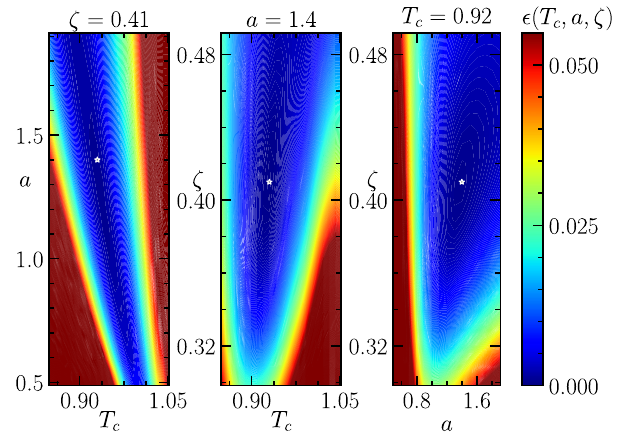
FIG. 15. Contour plot of the average residuals projected in the direction of the optimal parameters for the XY model. The white star points to the optimal parameters for our finite-size